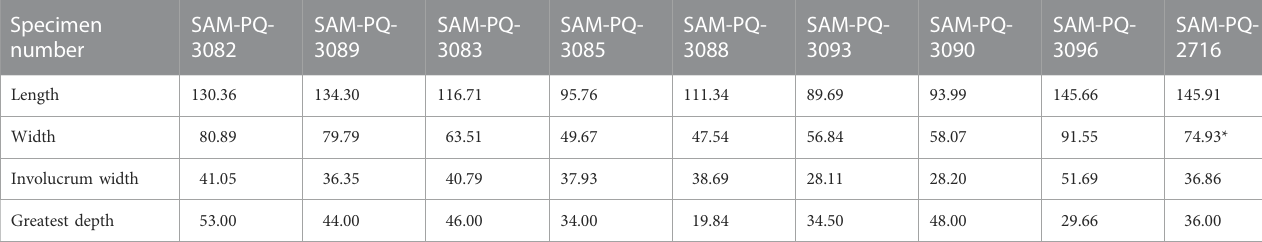
TABLE 1 Measurements (in mm) of isolated tympanic bullae from Saldanha Steel, Langebaanweg, Milnerton, and offshore trawls. Specimen number